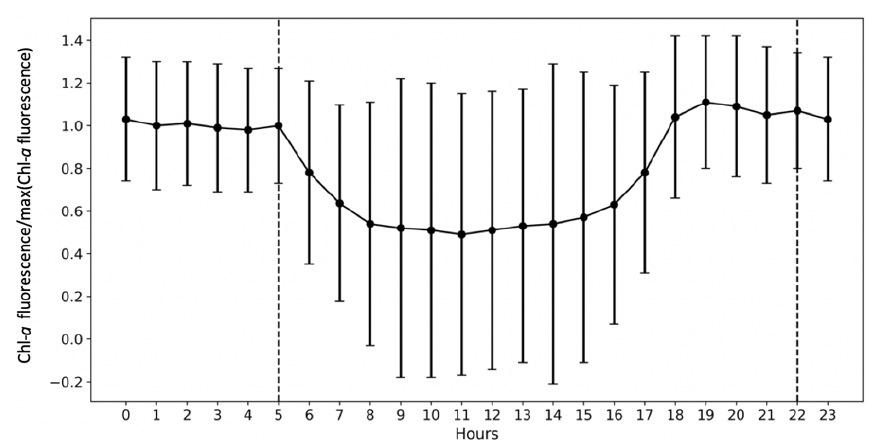
Figure 2. The importance of the quenching effect on Chl a fluorescence is represented by COAST-HF-Iroise data from 2000 to 2019. The standard deviation is represented by vertical black bars. The dashed lines represent the beginning and end of the selected values for the rest of the study from 22:00 to